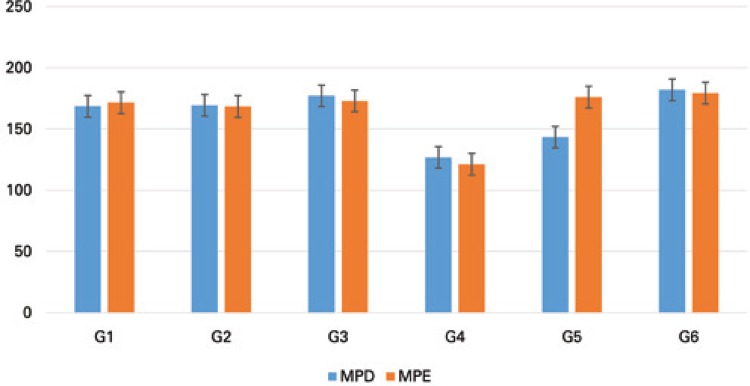
Espessura da cartilagem articular superior da tíbia, comparando-se as ratas distribuídas entre os grupos de estudo (G1, G2, G3, G4, G5 e G6) e os membros posteriores direito (alvo) e esquerdo (controle). Letras iguais significam semelhanças e letras diferentes significam diferenças significativas entre os grupos experimentais, para o mesmo lado